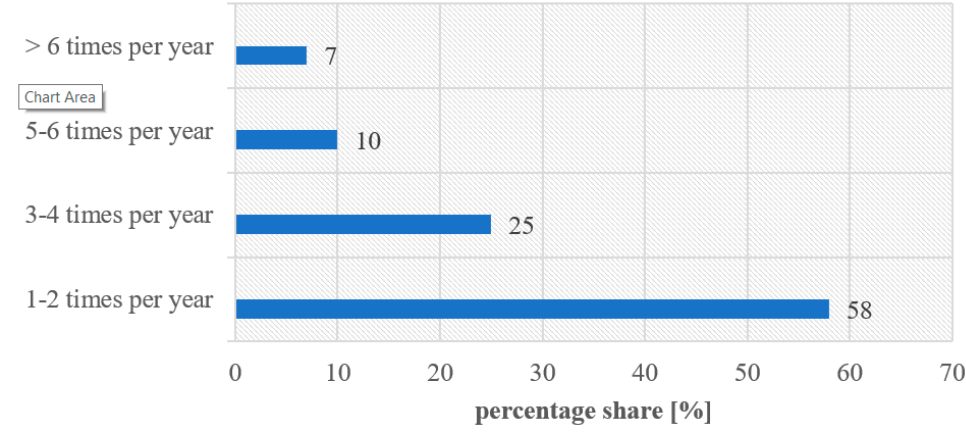
Figure 4. Frequency of purchase of fertilizers.